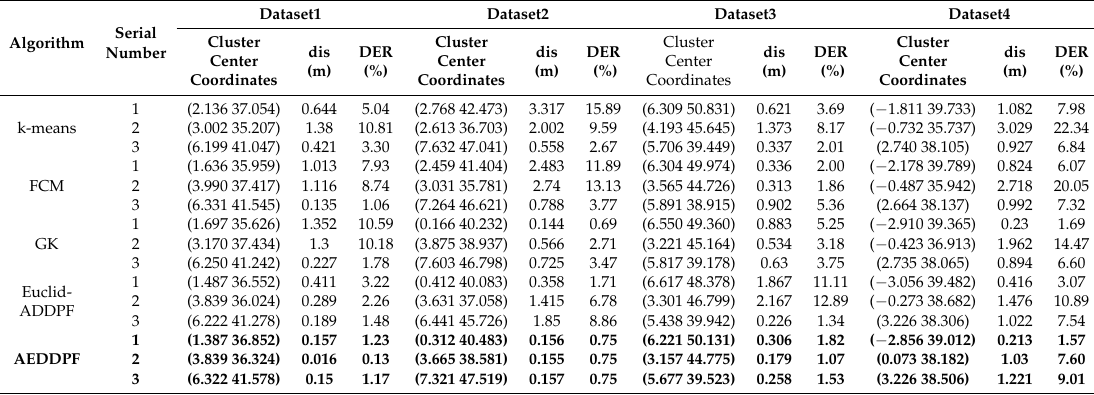
Table 2. Cluster center point